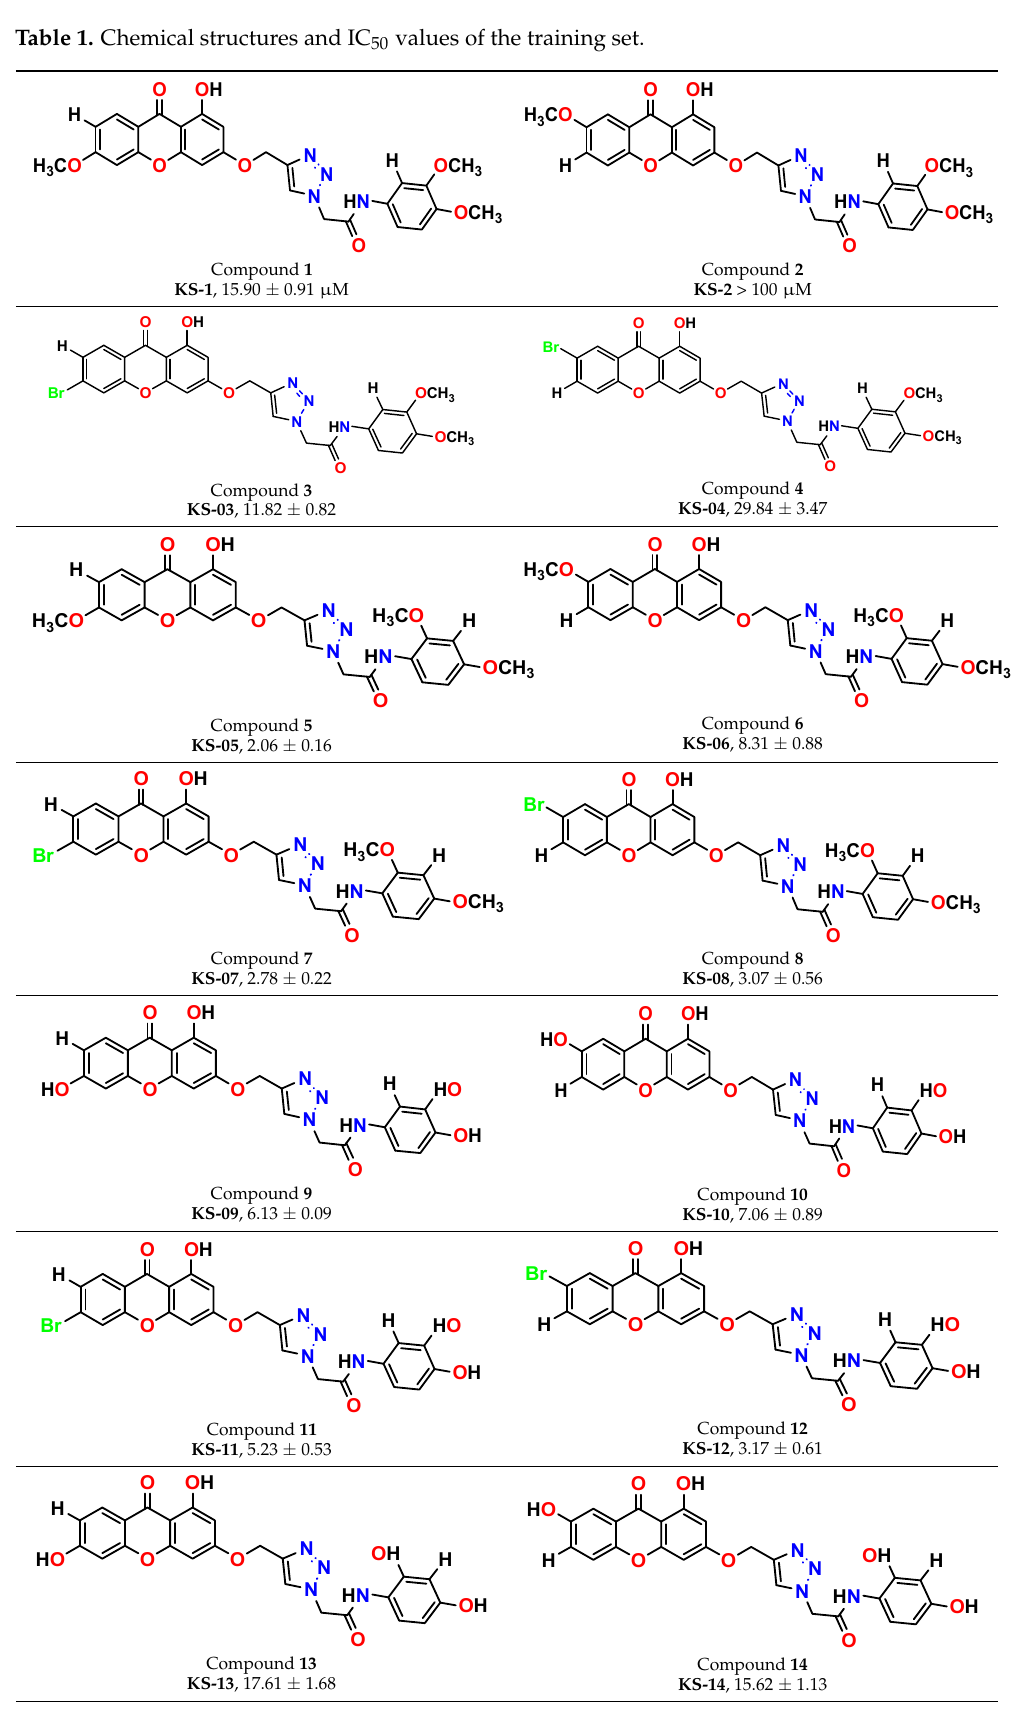
Table 1. Chemical structures and IC 50 values of the training set.